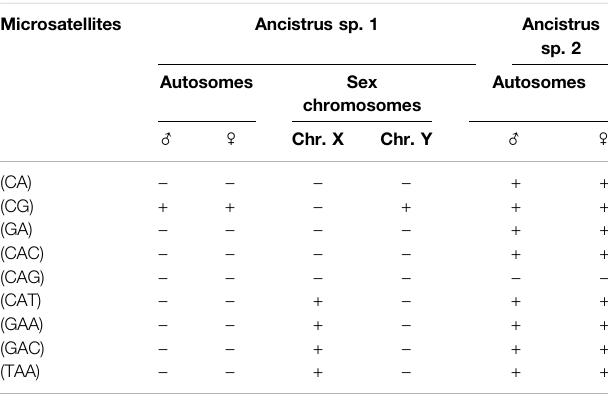
TABLE 2 | Comparative analysis of the presence/absence and location of microsatellite sequences between the karyotypes of the Ancistrus species analyzed in this